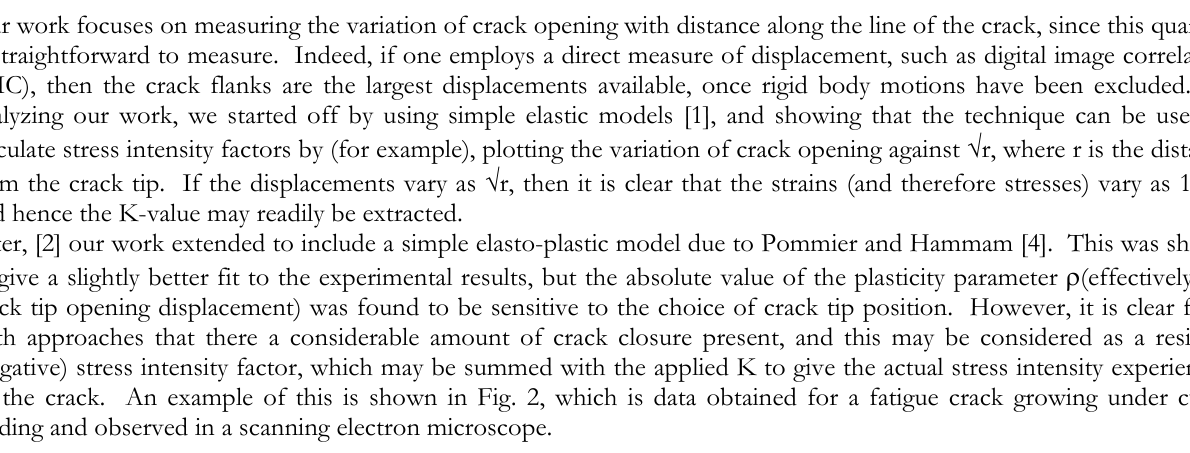
Figure 1: Typical image of a fatigue crack, during in-situ loading in the SEM